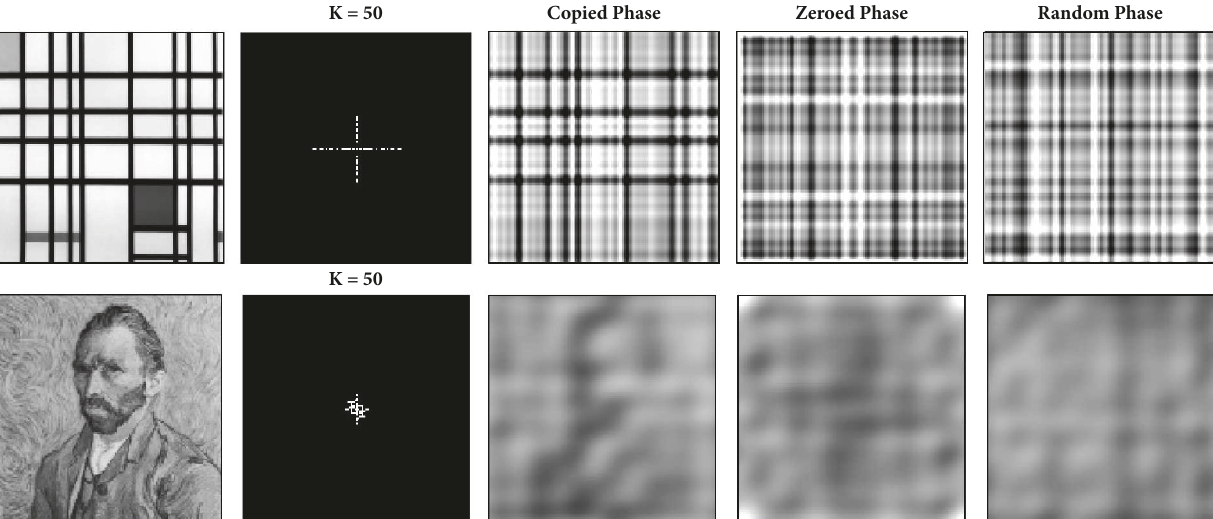
Figure 6: Reconstructing target images with varied phase. A pair of targets were chosen for reconstruction with a truncated set of Fourier amplitudes paired to different phase angle values. By zeroing power in all positions except the top 𝐾 = 50 most powerful positions, we can see the most salient positions alongside the target in the second column. The third column is the inversed FFT reconstruction with power limited to these truncated positions. We also show reconstruction variants using the same truncated amplitude set, but with zeroed phase angles, or phase angles which have been produced randomly. This may adjust expectations for the types of images evolved when phase is not